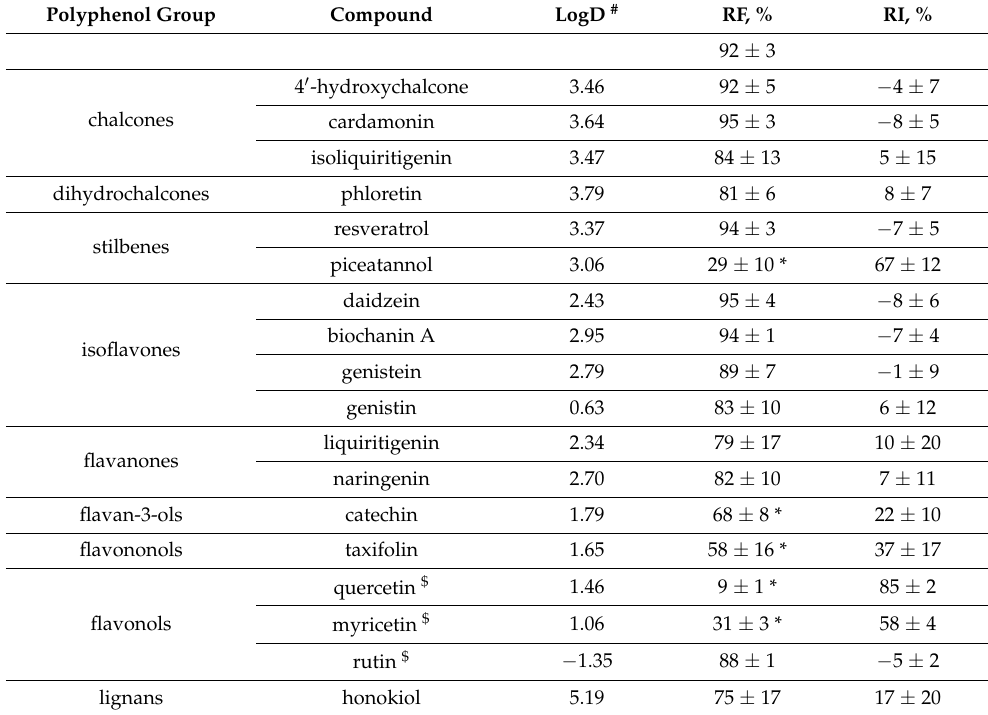
# the values of the logarithm of octanol/water distribution coefficient at pH 7.4 (LogD) were pre- dicted with ChemAxon. $ —according to [60]. *— p ≤ 0.01 (Mann − Whitney − Wilcoxon’s test, inductor alone vs. inductor +